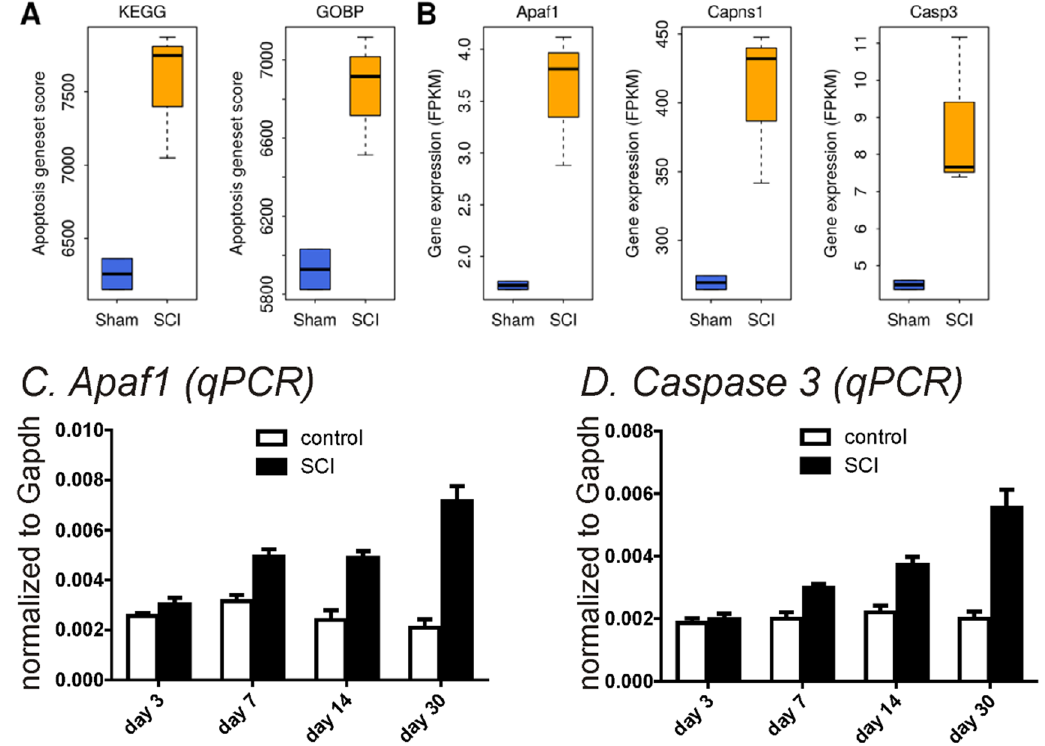
Figure 4. SCI -induced alteration in apoptosis-related genes by RNA-seq (A,B) and qPCR (C,D) . ( A ) Apoptosis geneset scores upregulated in SCI for both the KEGG and GOBP definitions. ( B) Expression of three apoptosis- related genes were upregulated in SCI. (C,D) . qPCR from sorted PDGFRα + cells in SCI up to 30 days showed an increased in apoptosis-related transcripts ( Apaf1 in ( C) and Caspase3 in ( D